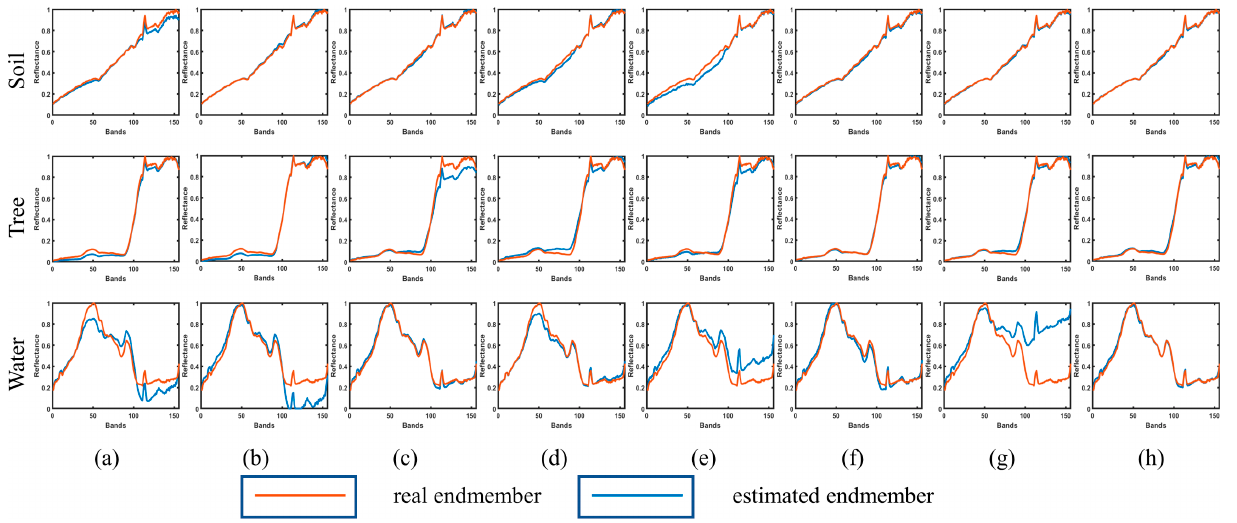
Figure 12. Visualization results of the endmembers of Samson data. ( a ) VCA-FCLS. ( b ) SGCNMF. ( c ) DAEU. ( d ) MTAEU. ( e ) MTAEU. ( f ) CyCU-Net. ( g ) MiSiCNet. ( h ) SSANet.